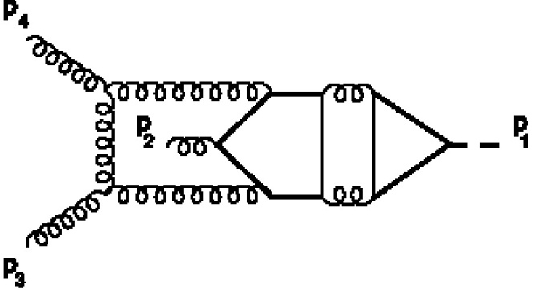
Figure 28. Non planar four loop contribution to H + j production.